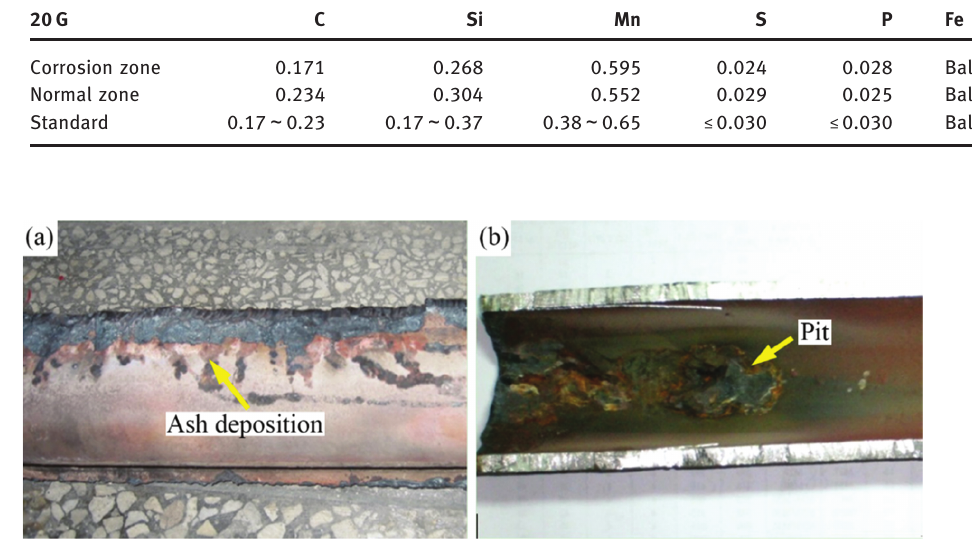
Figure 1: Macroscopic corrosion morphology of tube located fire-facing side.